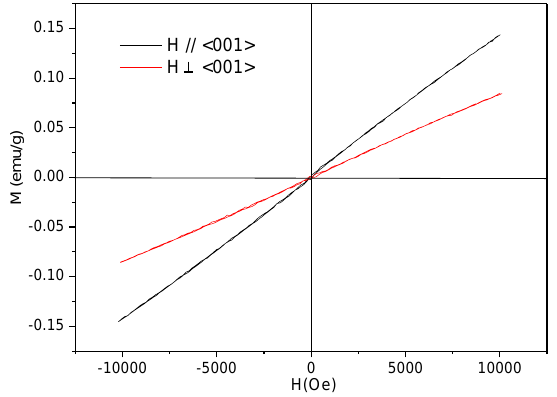
Figure 6. Magnetization curve of CeAlO 3 crystal at different directions.